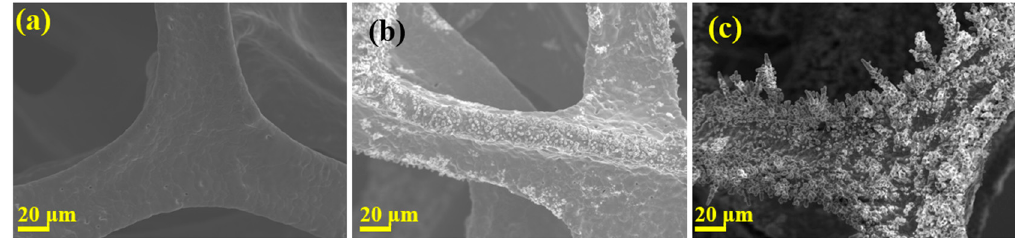
ff erent samples ( a ) CF#0s; ( b ) CF#195s; ( c ) Figure 6. SEM images of different samples ( a ) CF#0s; ( b ) CF#195s; ( c ) CF#255s. Figure 6. SEM images of di